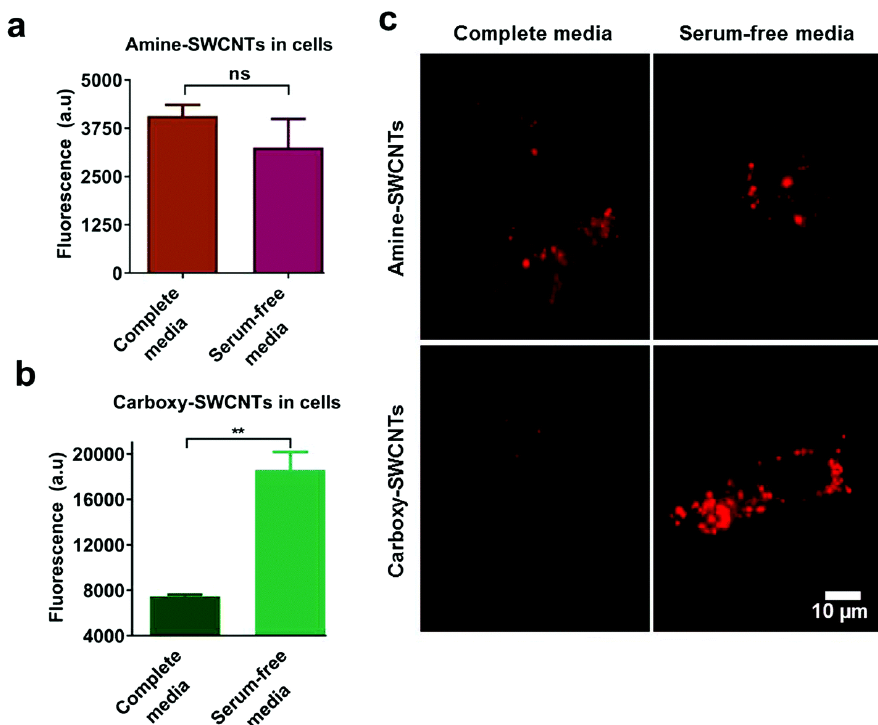
Figure 10. Effect of serum on uptake of polymer-single-walled carbon nanotubes (SWCNTs). Fluorescence emission from HeLa cell-associated ( a ) amine-SWCNTs and ( b ) carboxy-SWCNTs. ( c ) Representative near-infrared photoluminescence images of internalized SWCNTs in HeLa cells. Reprinted from [128] with permission from The Royal Society of Chemistry.